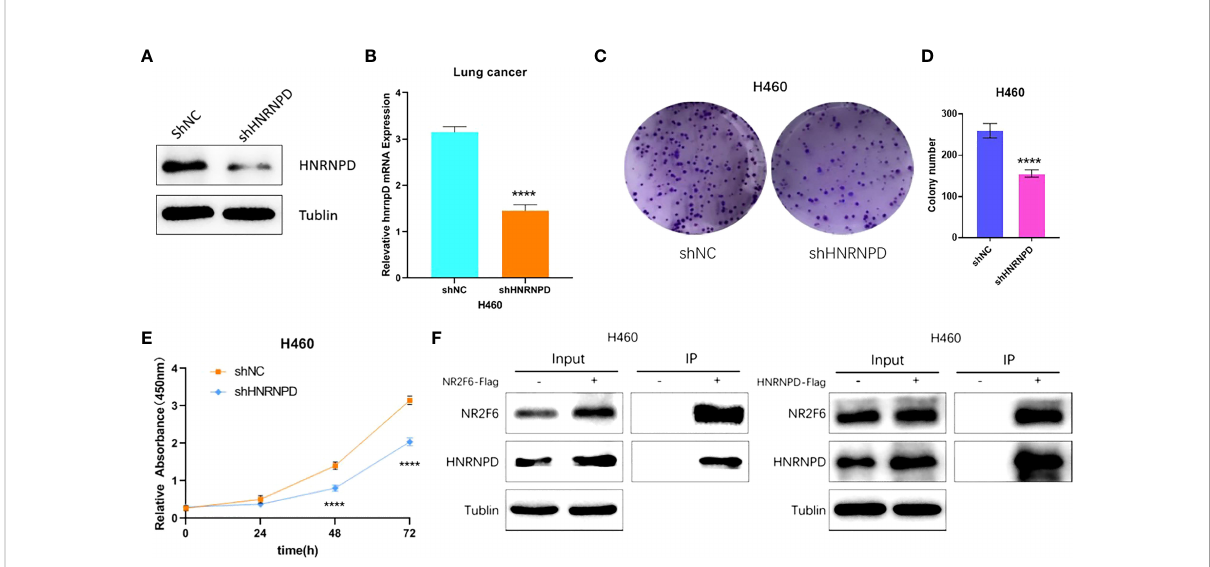
FIGURE 6 HNRNPD may interact with NR2F6 to jointly regulate lung cancer progression. (A) Western blot test of HNRNPD protein levels in H460 cells and stale knockdown ef fi ciency. (B) Quantitative polymerase chain reaction test of HNRNPD mRNA levels in H460 cells and knockdown ef fi ciency. (C, D) The knockdown of NR2F6 could reduce the clonality of H358 lung cancer cells. (E) The CCK8 results showed that the knockdown of NR2F6 signi fi cantly inhibited cell proliferation. (F) Co-immunoprecipitation veri fi cation of NR2F6 and HNRNPD interaction. ***** P <